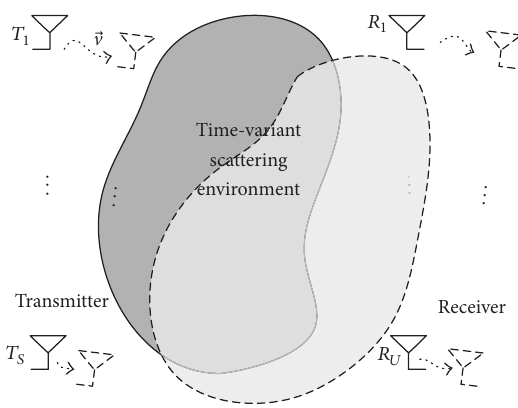
Figure 1: MIMO communication system with 𝑆 transmitting anten- nas and 𝑈 receiving antennas under mobile to mobile (M2M) sce- nario. The solid line and dash line indicate the positions of tran- sceiver antenna arrays at two different time